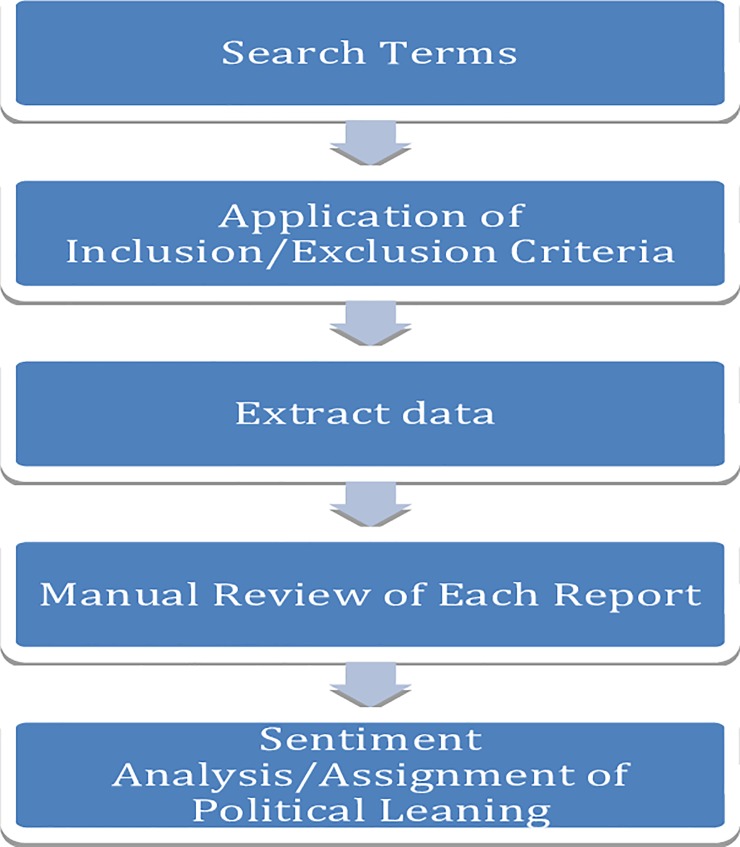
Report collection and data entry.